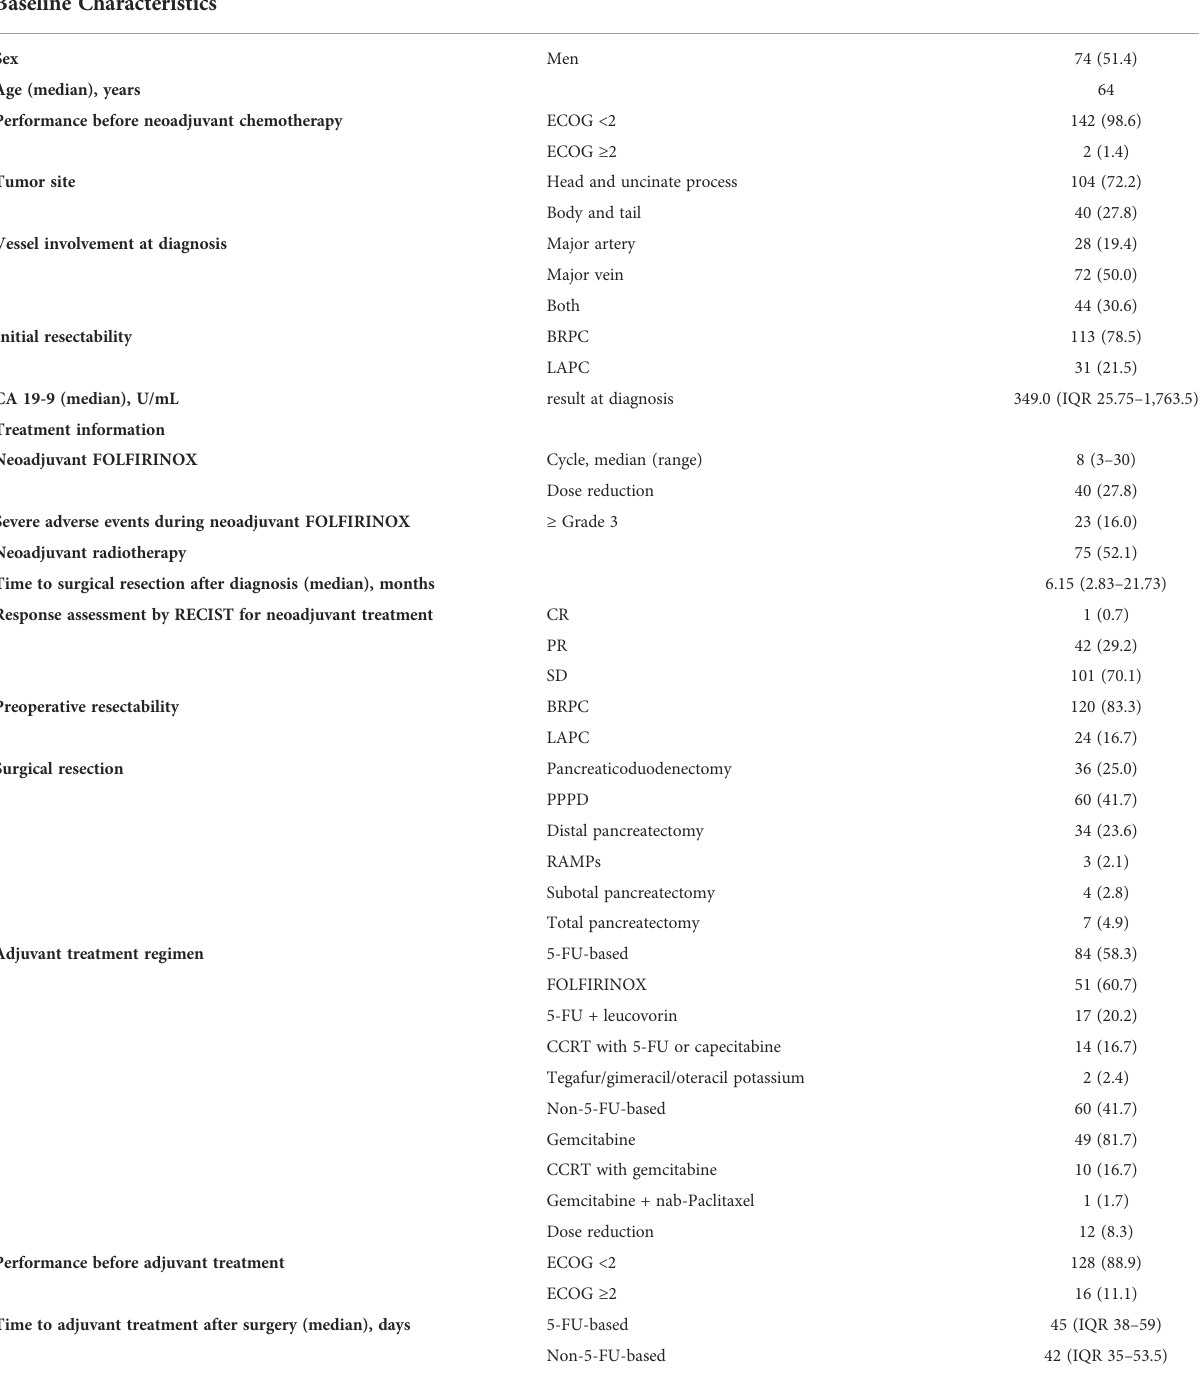
TABLE 1 Baseline characteristics and treatment